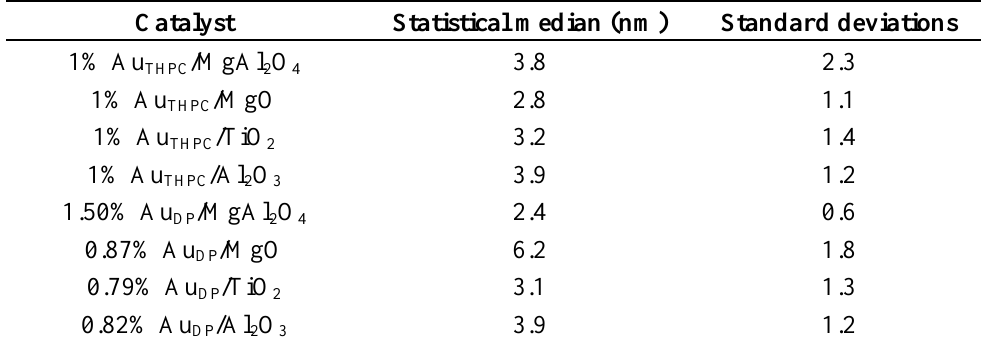
Table 1. Statistical median and standard deviation of particle size analysis for Au